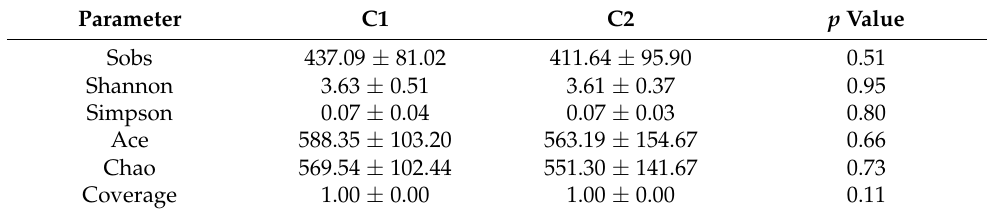
Indexes of intestinal flora diversity of the sleep—normal group before and after exercise